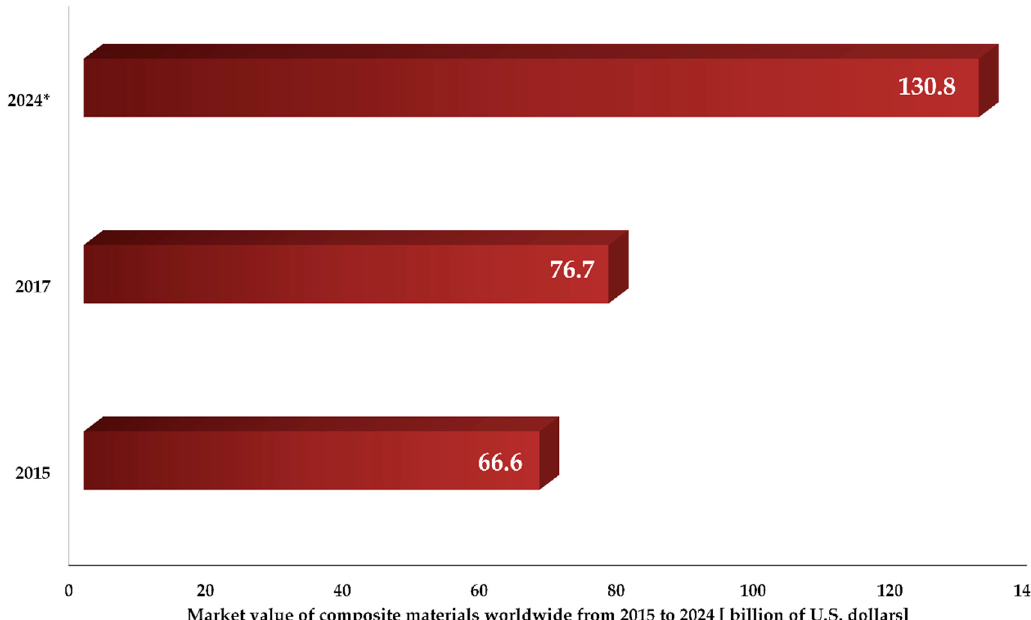
Figure 6. Composite material global market revenue, with a prediction for 2024 as reported by Grand Vie Research Center [269] .